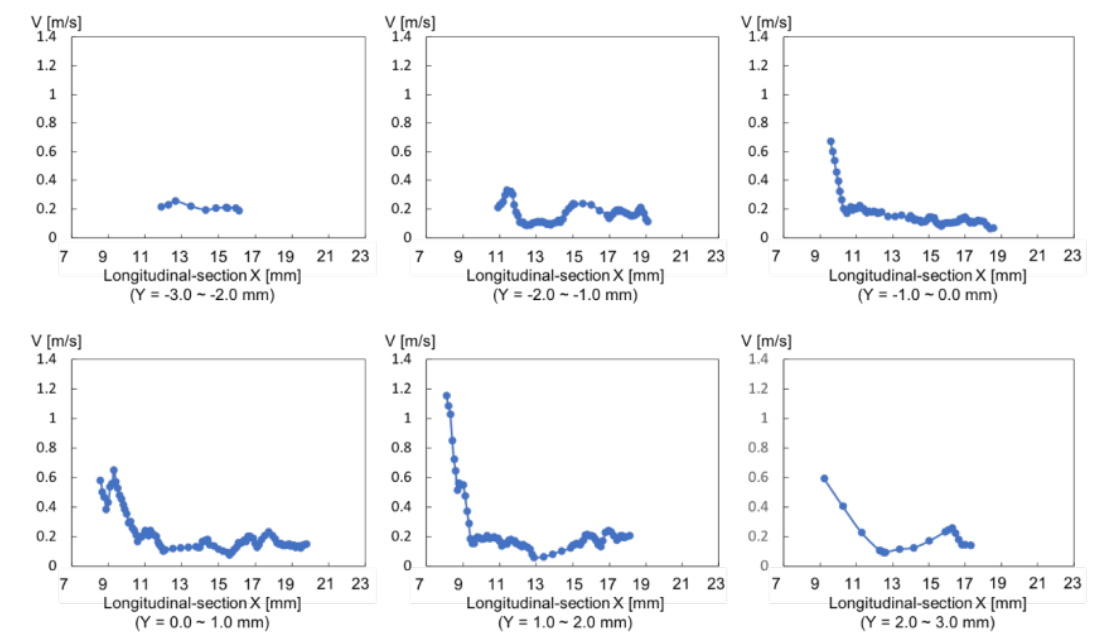
Figure 8. Flow velocity graph around the ending part in the case of 160 A. The velocity distribution on the upper side in the case of 120 A is exhibited in Figure 9.